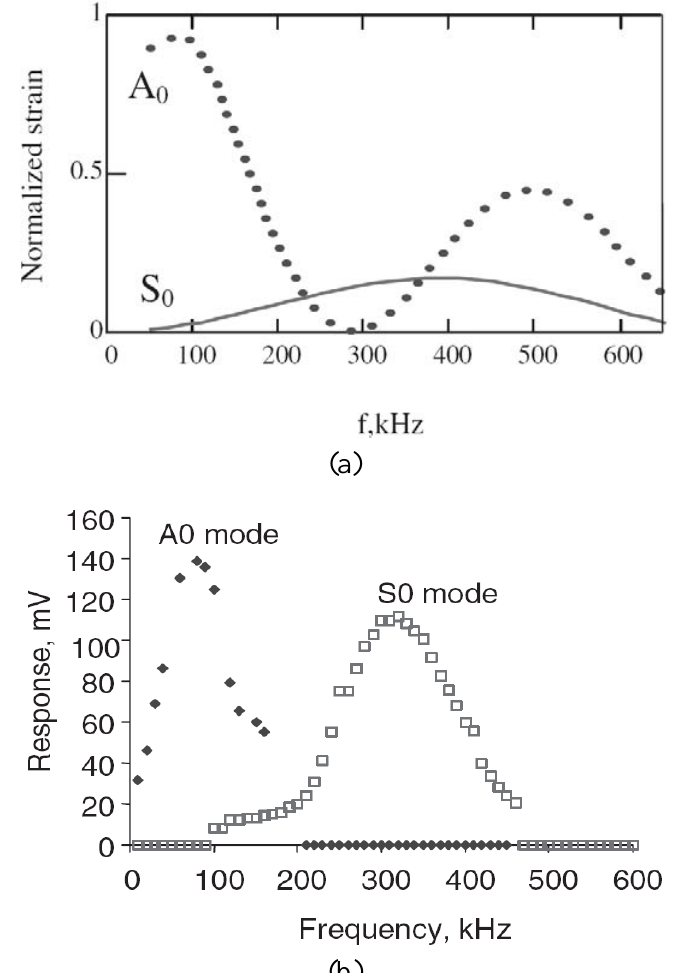
Figure 12. Lamb wave mode tuning with varying excitation frequencies (a) the simplified pin-force model and (b) the experimental testing. Taken from Giurgiutiu